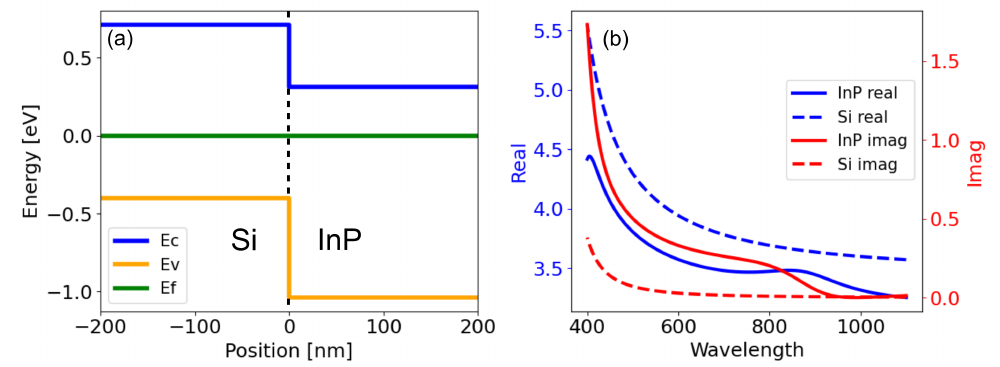
Figure 1. ( a ) Energy band diagram of a InP/Si heterojunction showing the type-II band alignment. Energy levels of the conduction band (Ec), valence band (Ev) and Fermi level (Ef) are depicted by the blue, orange and green lines, respectively. ( b ) Real and imaginary parts of the refractive indices of InP and Si used in the